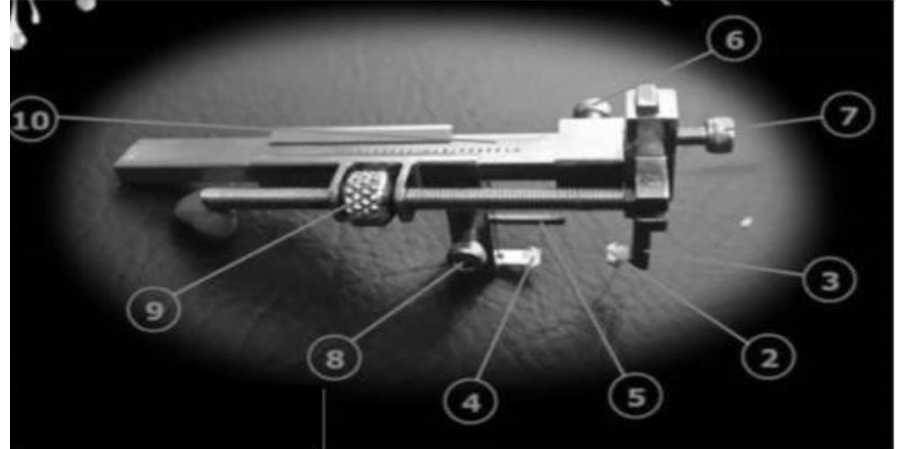
Fig. 3. DT3C Device. (1) Lingual arm. (2) Lingual arrow blade. (3) Labial arm. (4) Labial arm blade. (5) Vertical stop. (6) depth lock. (7) Lingual arm lock. (8) vertical stop lock. (9) Guiding screw & nut. (10) Horizontal